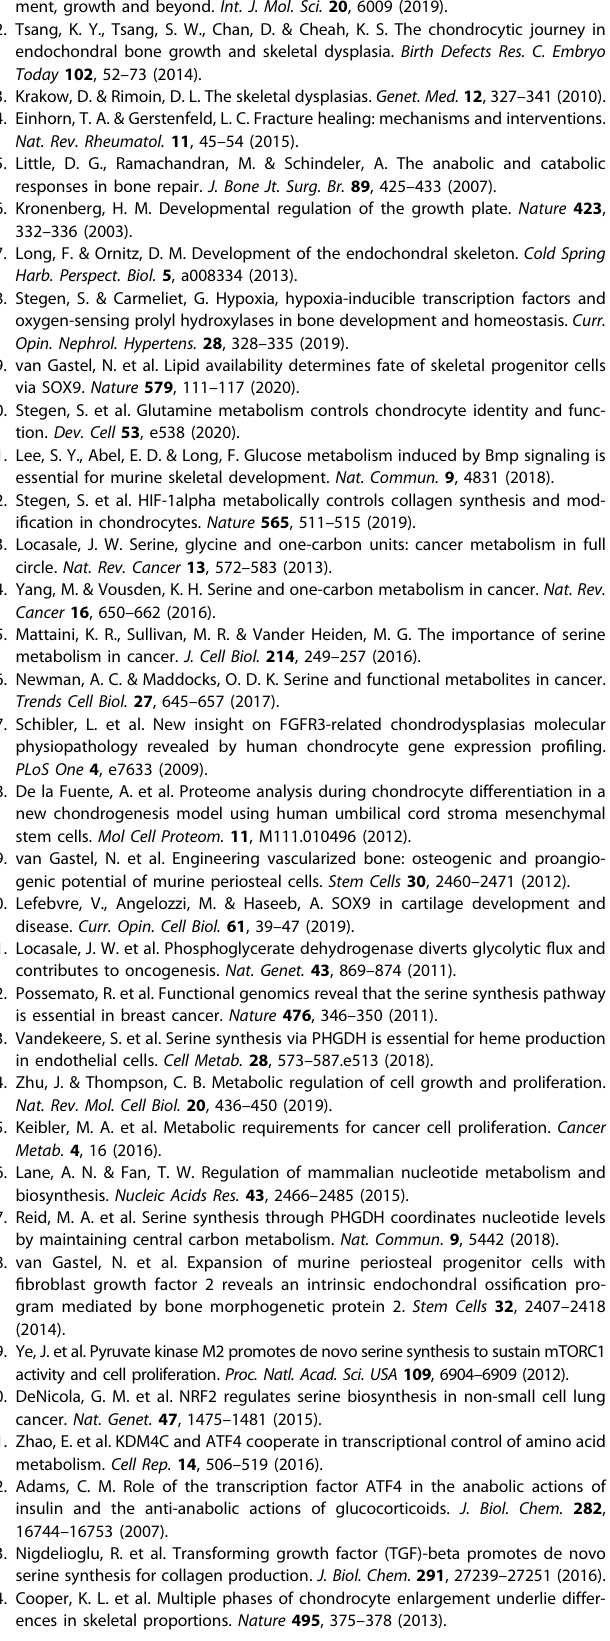
Figure artwork Figure artwork was created with